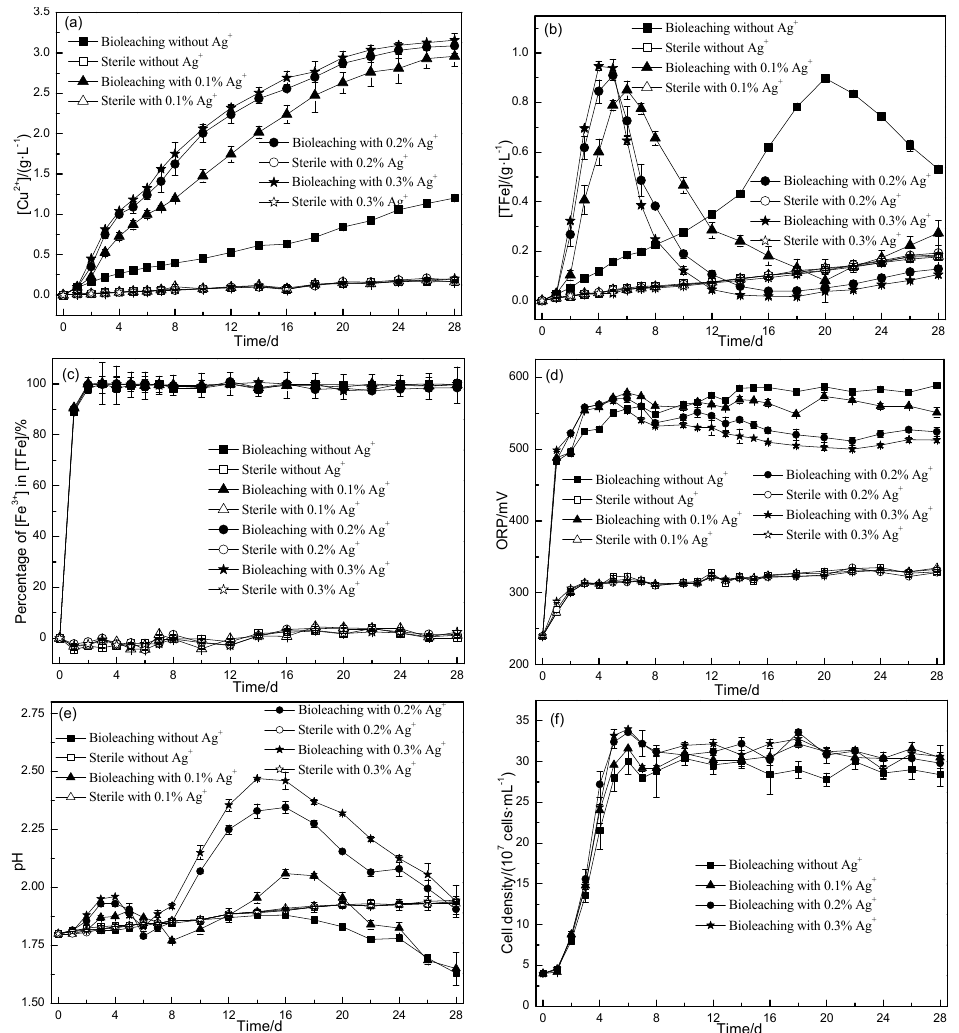
Figure 3. Leaching parameters of chalcopyrite by thermophilic culture and in sterile experiments, both at 48 °C with 0, 0.1%, 0.2% and 0.3% of Ag + . The leaching parameters were characterized by [Cu 2+ ] ( a ), [TFe] ( b ), percentages of [Fe 3+ ]/[TFe] ( c ), ORP values ( d ), pH values ( e ) and cell density ( f